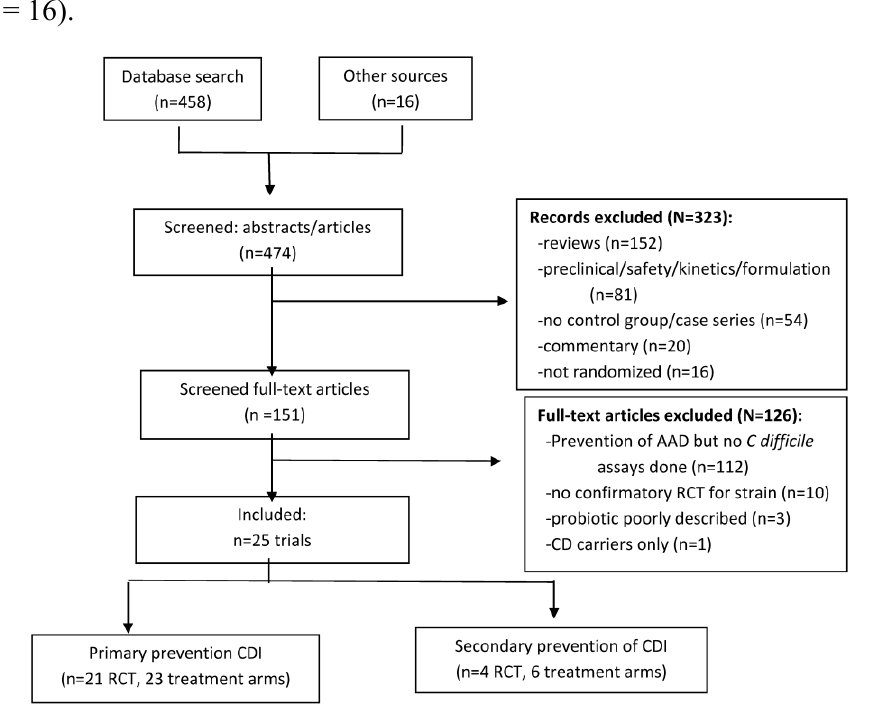
Figure 1. PRISMA flow-diagram of literature search of probiotics for primary or secondary prevention of Clostridium difficile infections